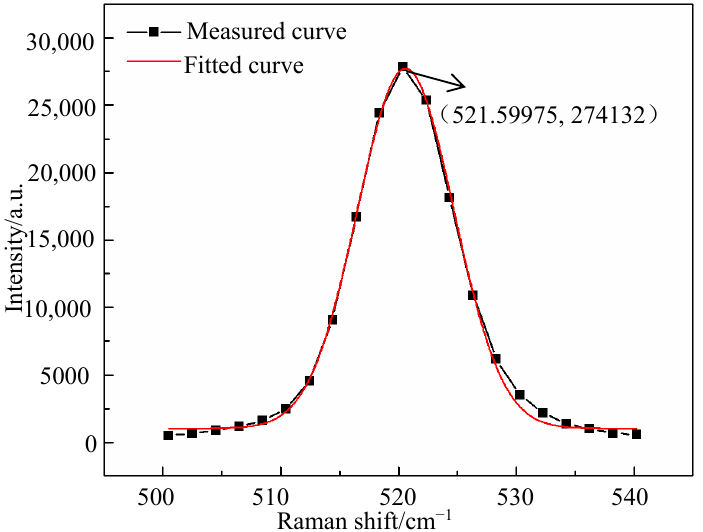
paper. For example, Figure 8 is the fitted Raman curve and measured curve. The R-square coefficient is 0.98835, which is close to 1, indicating the fitting function has a good fitting degree. It can be seen that the fitted value of the Raman peak is 521.59975 cm − 1 , which is larger than 521 cm − 1 , indicating that compressive stress exists at this point.